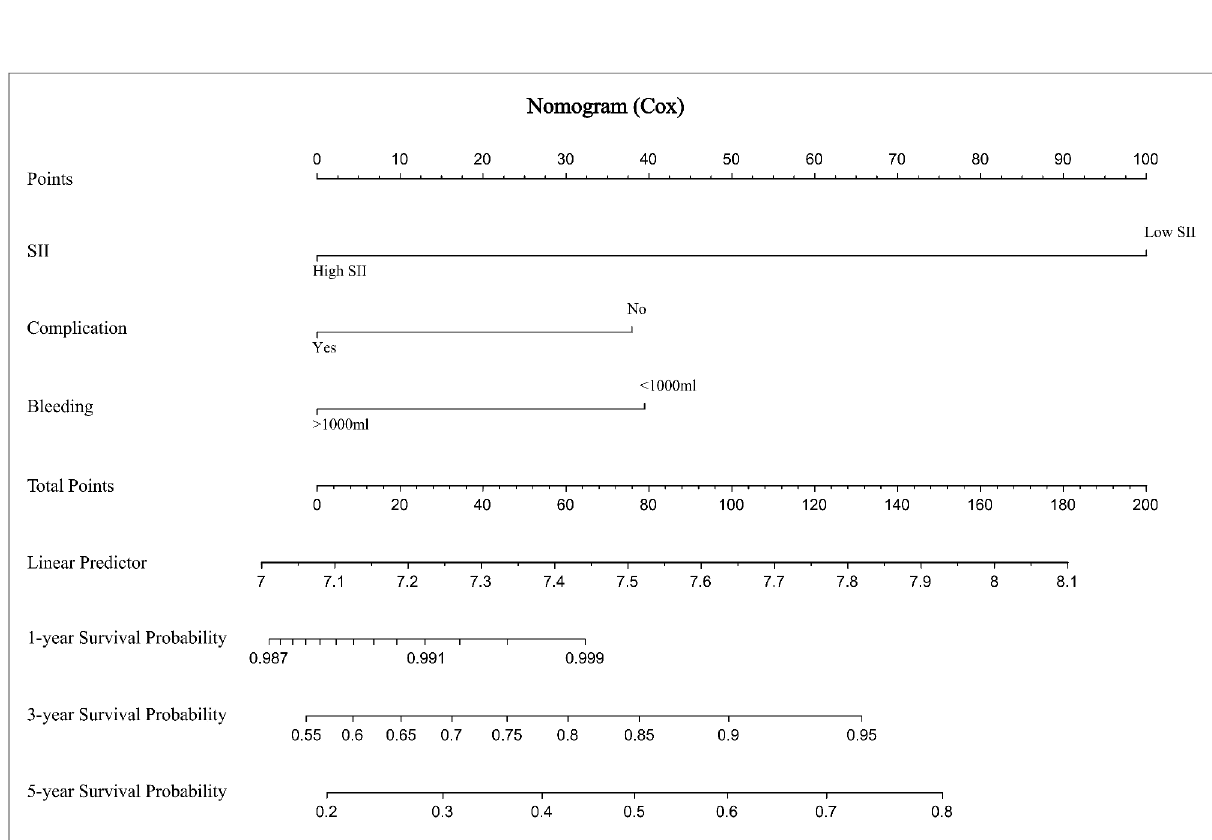
FIGURE 3 Prediction of 1-, 3-, and 5-year survival rates of patients with hepatic alveolar hydatid disease by